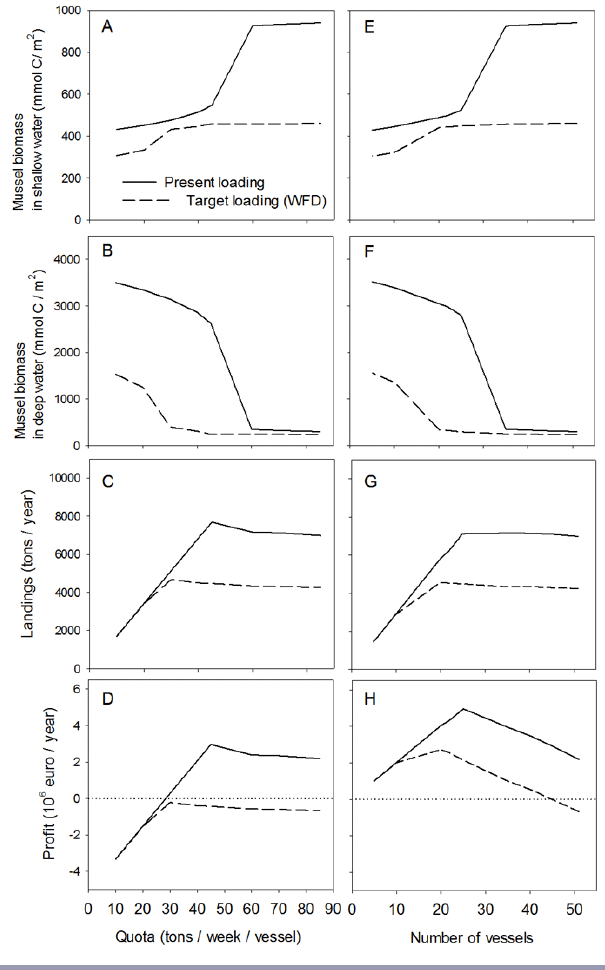
Fig. 6 . Model scenarios showing the effects of fishing quotas with a constant number of vessels (A-D) and with a variable number of fishing vessels but a constant quota of 45 tons/week/ vessel (E-H) under the current nutrient load level (solid line) and after implementation of the Water Framework Directive (dashed